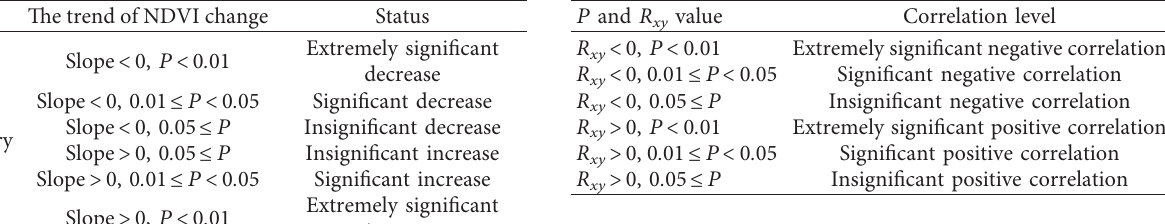
Table 1: Classified result of NDVI change simulated from 2001 to 2018. Items The trend of NDVI change